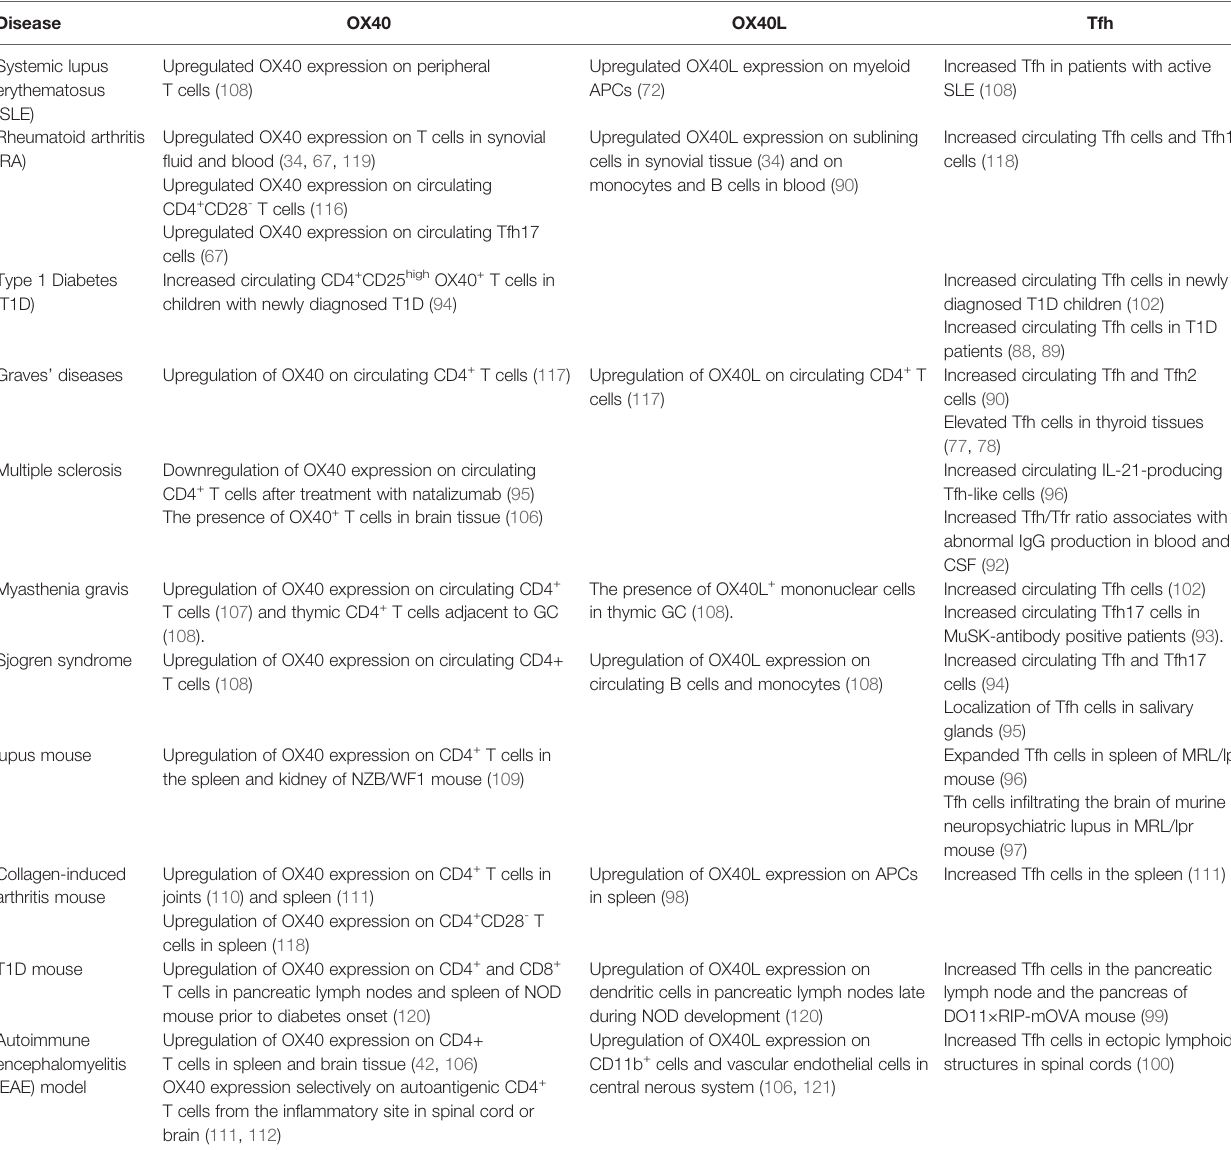
TABLE 2 | OX40, OX40L expression and Tfh cells in autoimmune diseases.